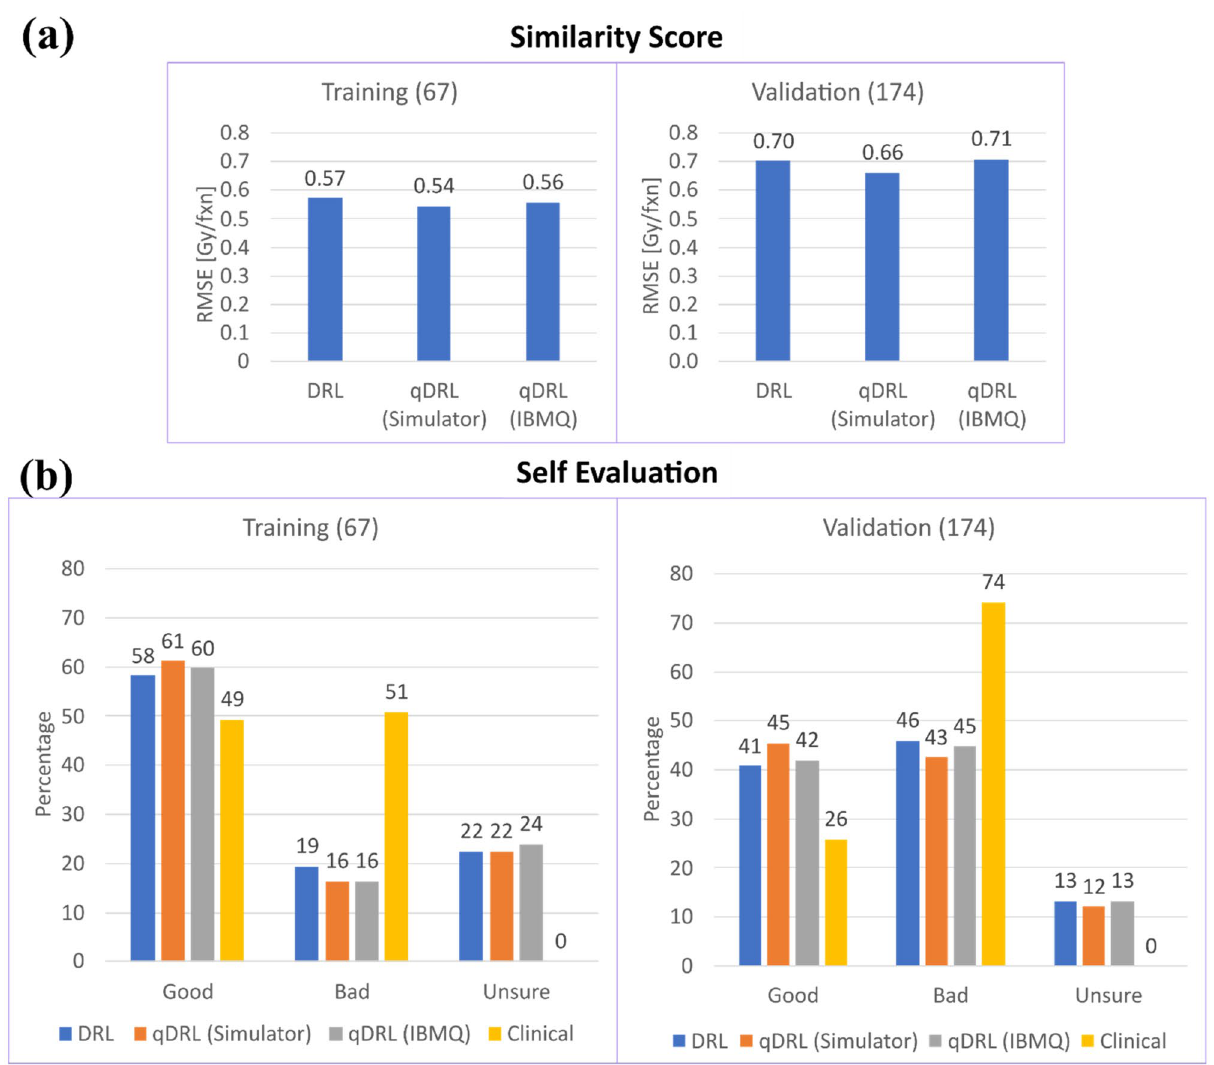
Figure 4. Training and validation results. ( a ) similarity scores and ( b ) self-evaluation results for the training and validation data sets. A total of 5 numerical experiments were carried out for each of the models: Deep reinforcement learning (DRL), quantum DRL (qDRL) trained in simulator, and qDRL trained in IBMQ quantum processor. In particular, we used Double DQN algorithm for DRL. All the results correspond to the average model. The results of the Self-Evaluation I scheme are converted into the percentage of the total patients. The similarity score is the root mean square error (RMSE) value between the retrospective clinical dose decision and the AI recommendation while the self-evaluation value is calculated based on the clinical outcome and the clinically established relationship between radiation dose and RT